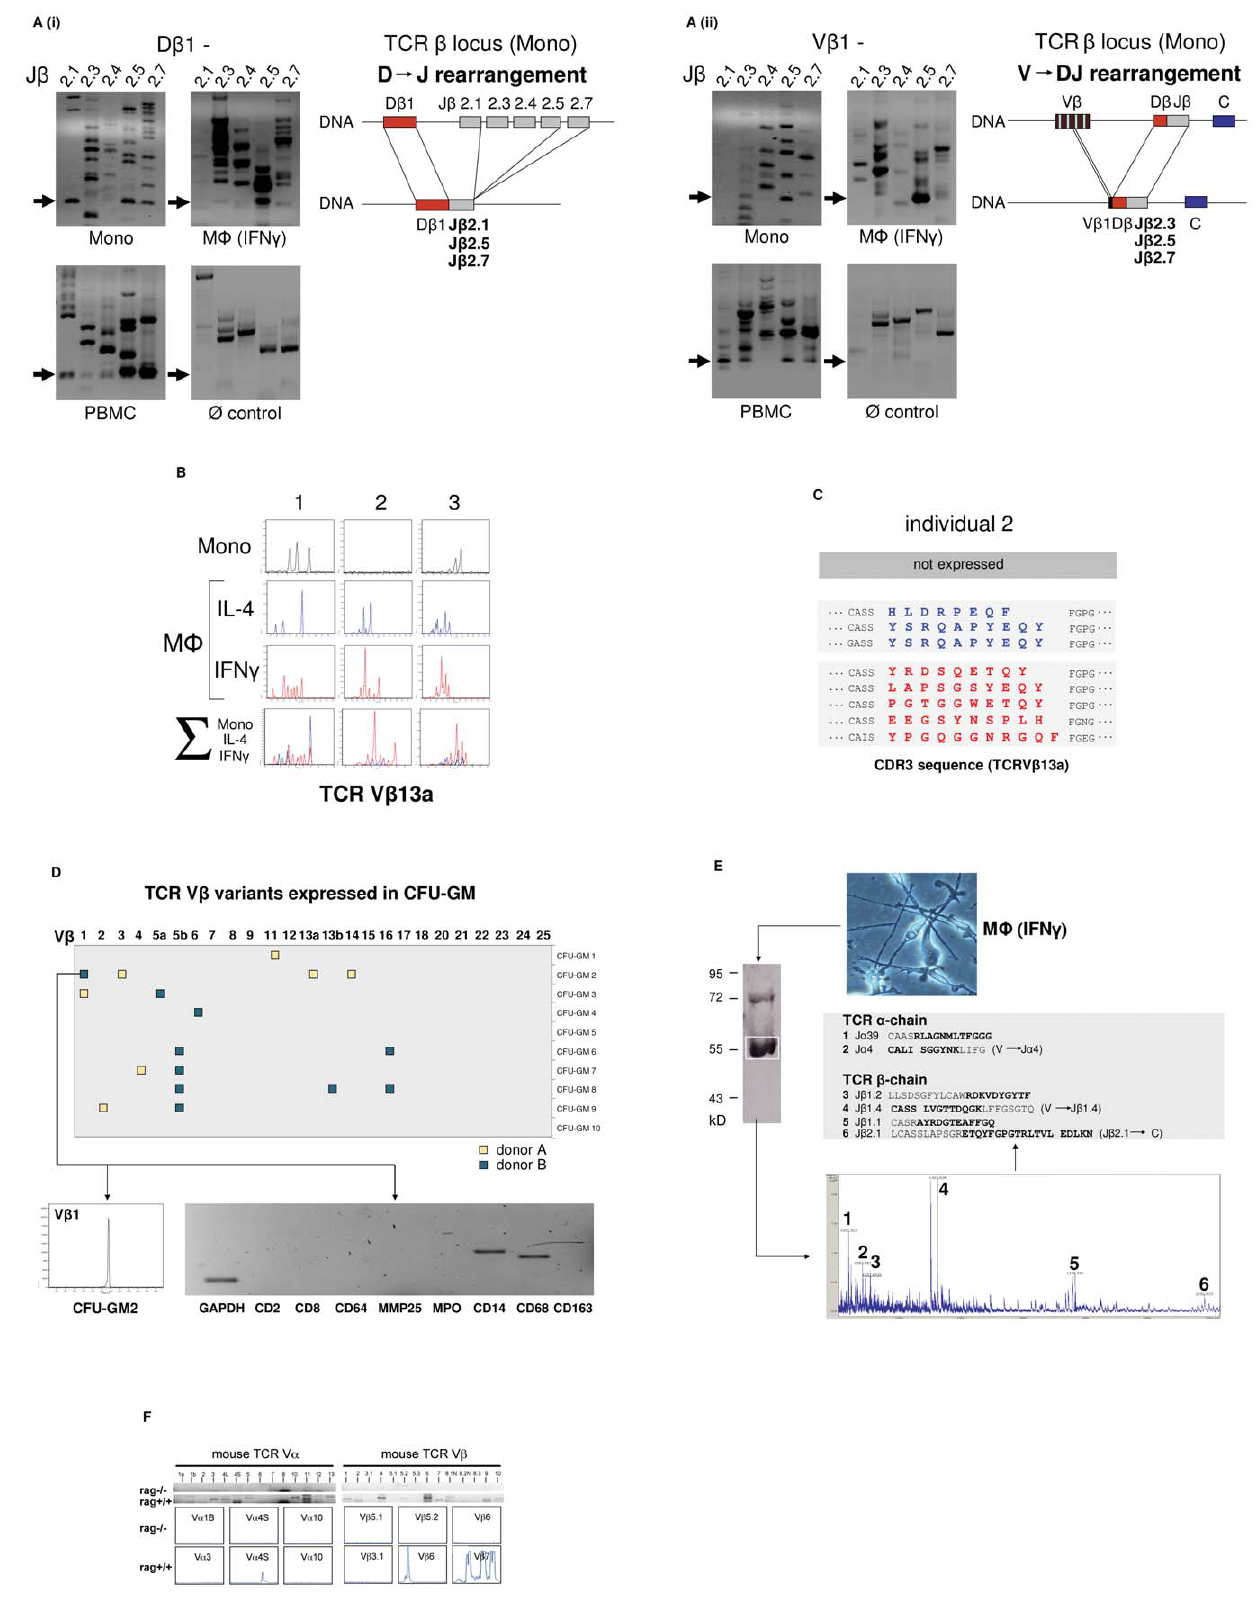
Figure 2. The monocyte/macrophage TCR ab is a recombinatorial receptor. ( A ) Detection of D R J (i) and V R DJ (ii) rearrangements in the TCR b gene locus of human CD14 + monocytes and IFN c macrophages. Arrows denote the presence of D b 1 R J b and V b 1 R J b rearrangements which were confirmed by sequencing. Genomic organization of the identified rearrangements is schematically drawn. Peripheral blood mononuclear cells